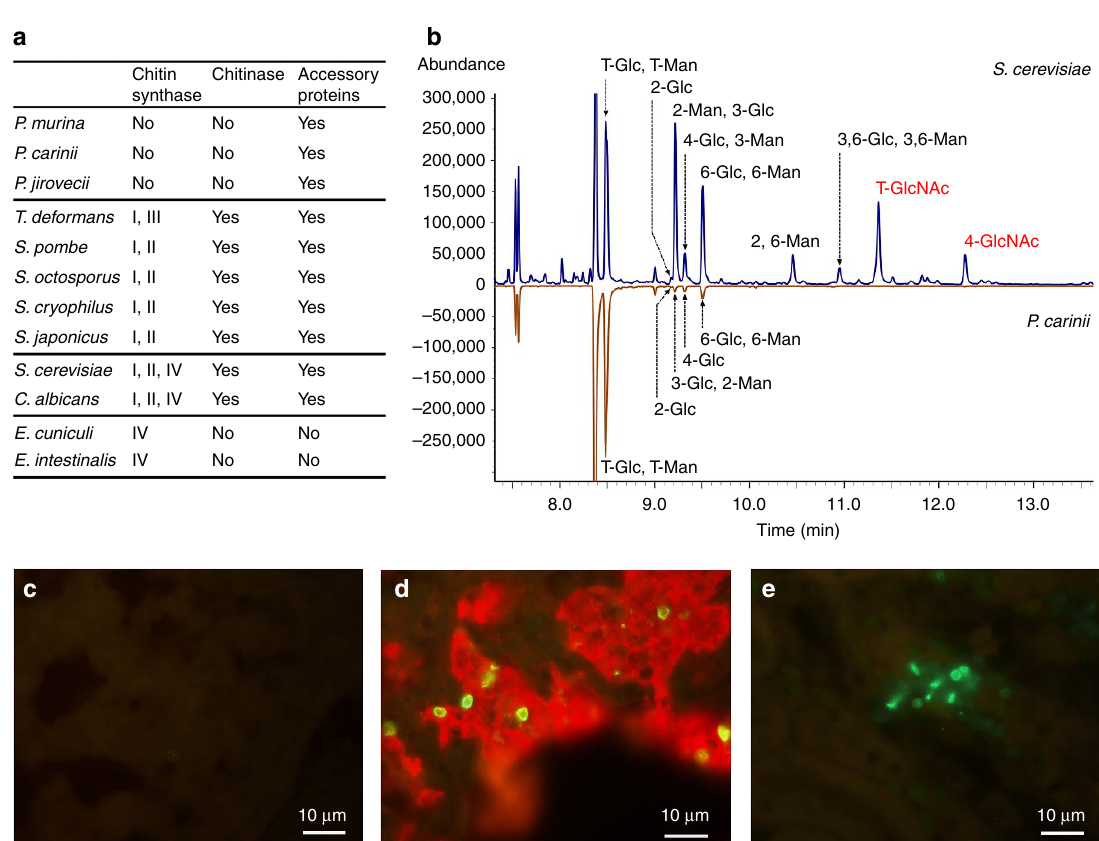
Figure 6 | Analysis of chitin in Pneumocystis and related fungi. ( a ) Enzymes and accessory proteins involved in chitin metabolism in fungi. Pneumocystis genomes do not encode any chitin synthase or chitinase, which are present in other fungi, but retain genes encoding four accessory proteins (Supplementary Data 17). ( b ) Gas chromatograms of partially methylated alditol acetates of P. carinii and S. cerevisiae (control) cell walls. Terminal and 4-linked N-acetylglucosamine signals (T-GlcNAc and 4-GlcNAc in red font) were detected in S. cerevisiae but not in P. carinii . Glucose (Glc) and mannose (Man) signals were detected in both species. ( c – e ) Detection of chitin with recombinant chitin-binding domain (Alexafluor 488) using P. murina -infected lung tissue ( c ) and C. albicans -infected kidneys ( e ) as a positive control. Pneumocystis organisms are demonstrated in d by dual staining with anti-Msg (red), which labels both trophic forms and cysts, and a dectin-Fc construct (green), which labels b -1,3-glucan in cysts. Chitin staining is absent in P. murina but readily detected in C. albicans , while b -1,3-glucan is easily seen in P. murina . Original magnification, (cid:2) 400; scale bar, 10 m